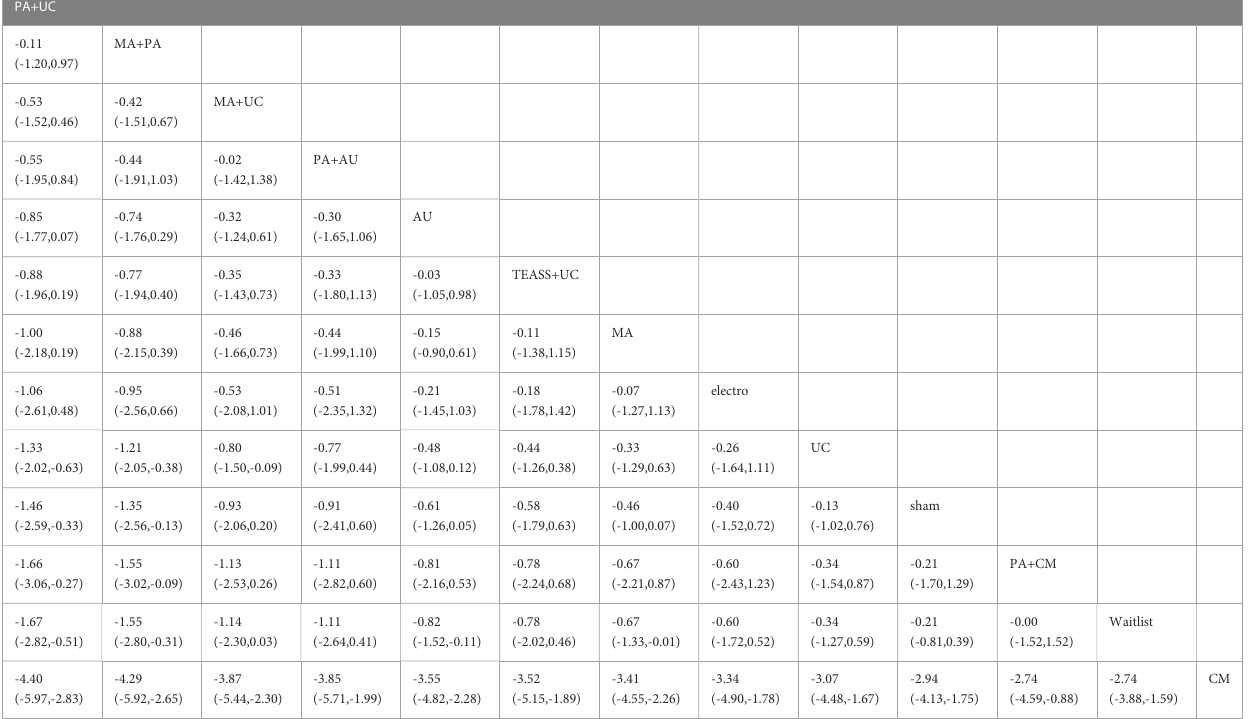
TABLE 4 The results of network meta-analysis of CFS